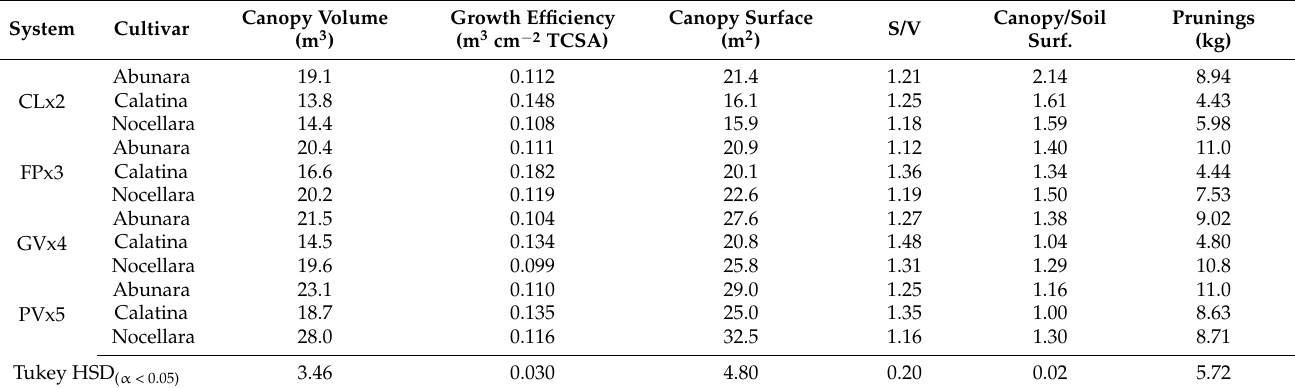
Table 1. Growth parameters for ‘Abunara’, ‘Calatina’, and ‘Nocellara del Belice’ olive trees grown as central leaders at 2 × 5 m (CLx2), free palmette at 3 × 5 m (FPx3), globe vase at 4 × 5 m (GVx4), and polyconic vase at 5 × 5 m (PVx5). Mean separation by Tukey’s honestly significant difference (HSD, p <